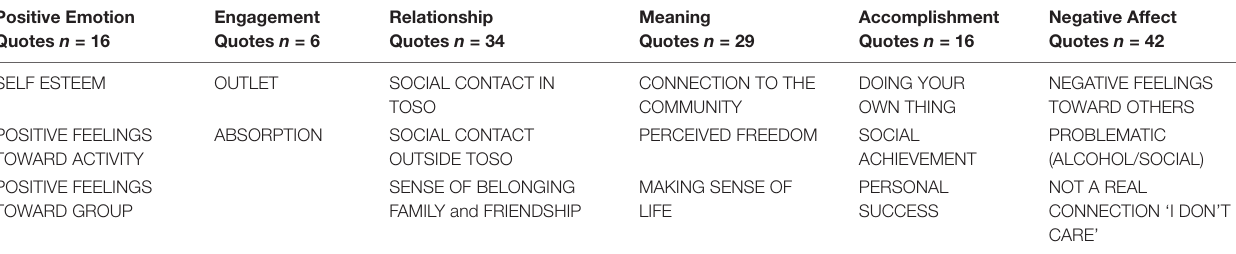
TABLE 1 | PERMA categories + negative affect (19